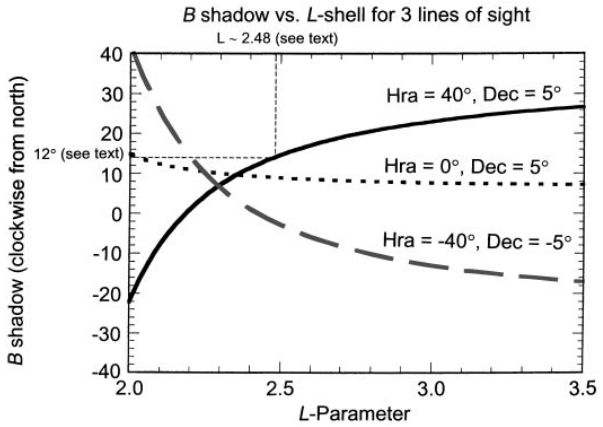
Fig. 8. Direction of B shadow (in degrees clockwise from north) as a function of the McIlwain parameter (cid:133) L (cid:134) for three different lines of sight. The hour angles and declinations for each line of sight appear next to each curve. The corresponding L parameter for a B shadow of 12 (cid:14) is approximately 2.48 for a line of sight with hour angle = 40 (cid:14) and declination = 5 (cid:14) (see text)